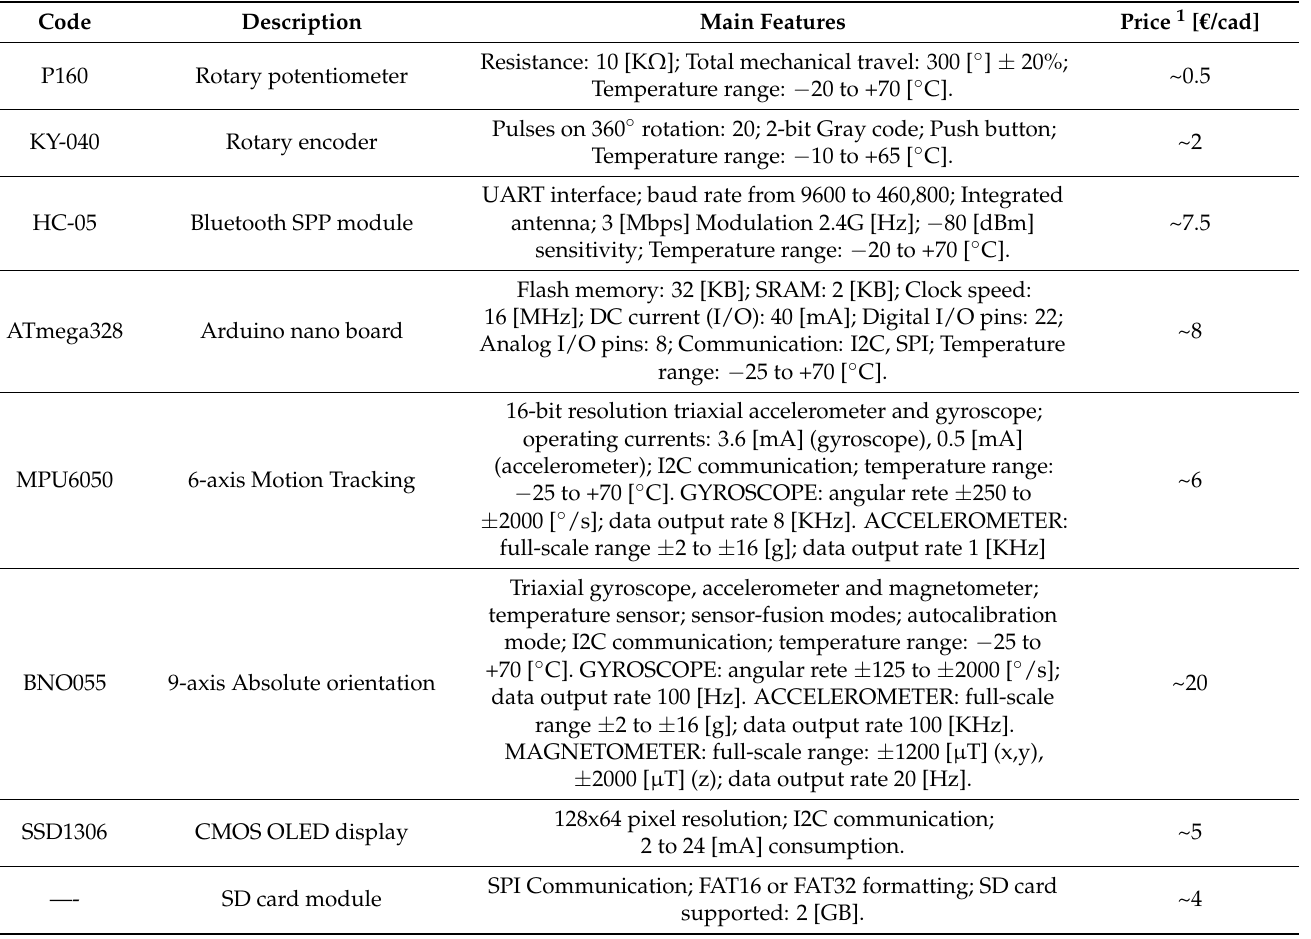
Table 1. Component list.